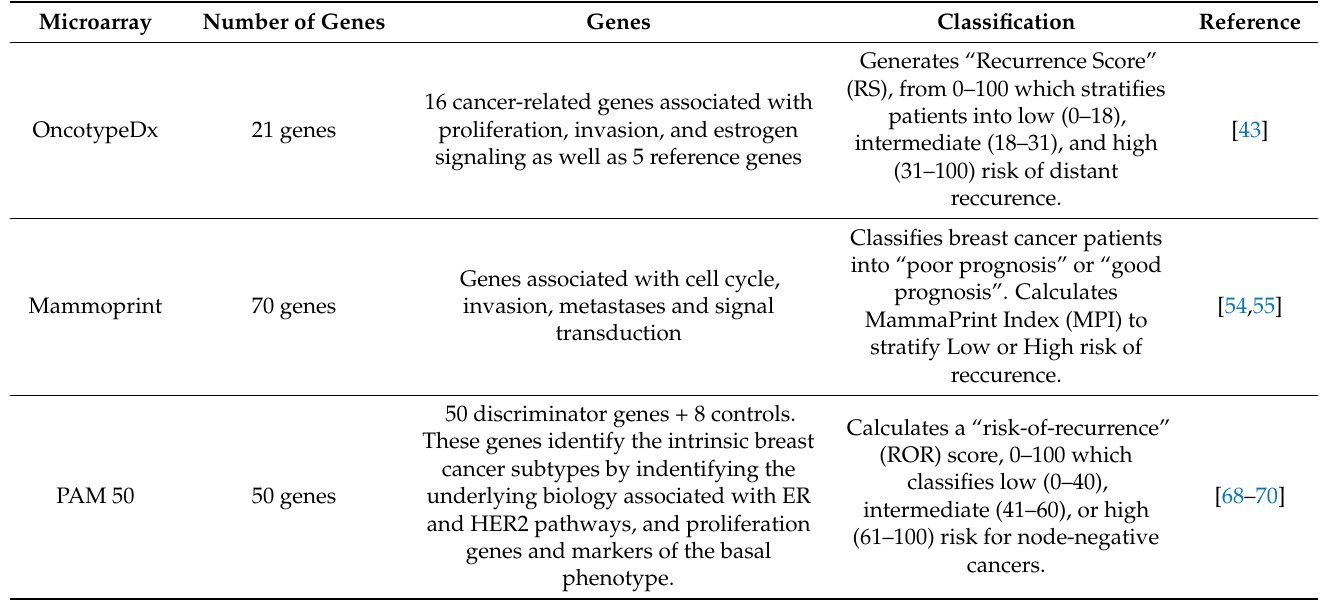
Table 1. Prognostic genomic assays in breast cancer.